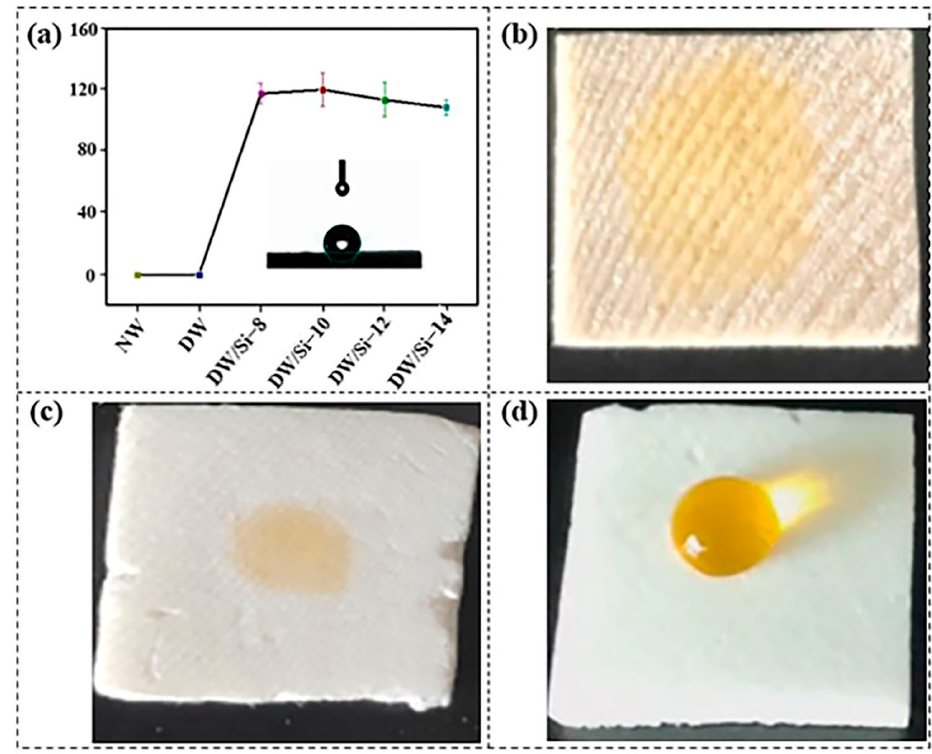
Figure 8. ( a ) WCAs of the samples. Water dropped onto the surface of ( b ) NW, ( c ) DW, and ( d ) DW/Si-10; the water was colored orange with methyl orange before the experiments; inset is the morphology of water droplets on the DW/Si-x material surface.